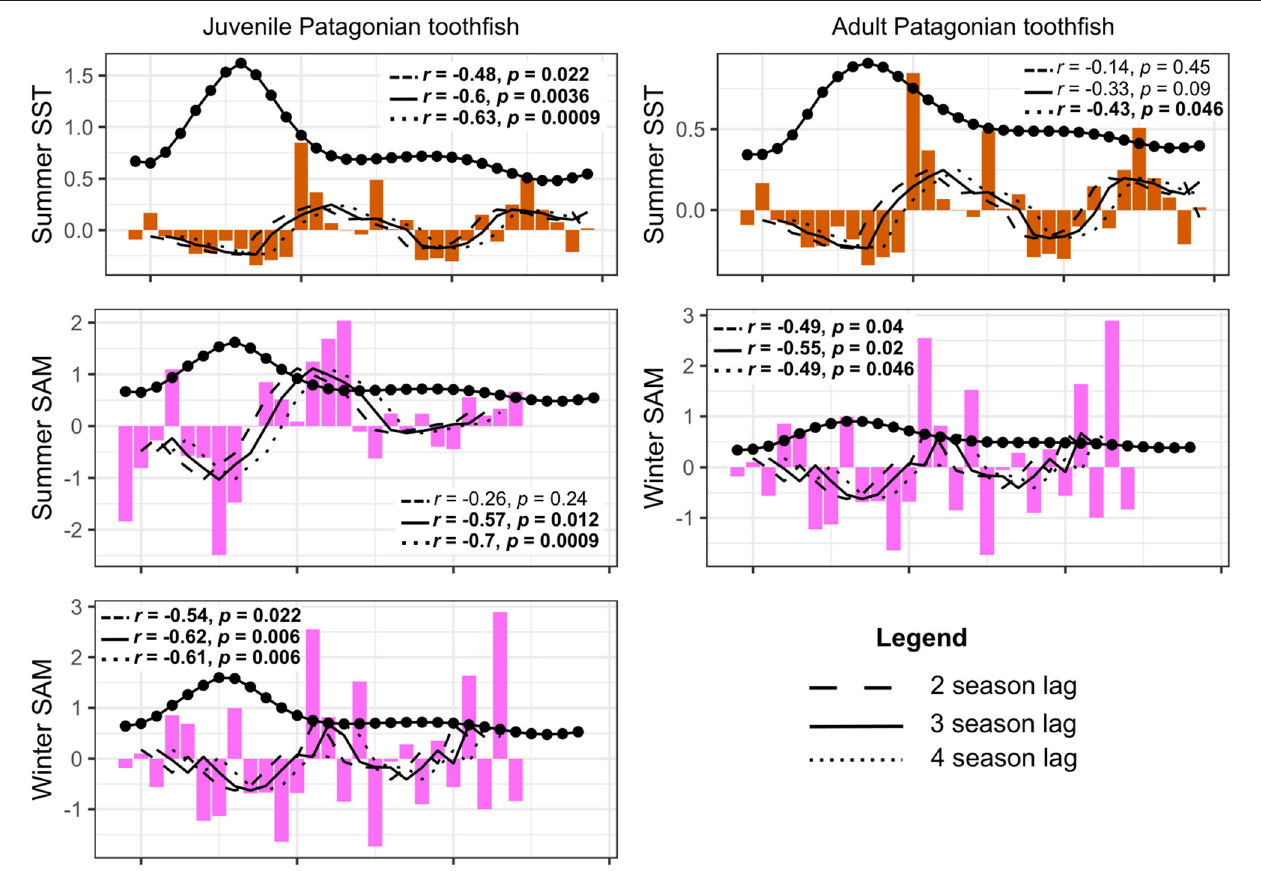
FIGURE 9 | Lagged toothfish biomass correlations to summer SST, summer SAM and winter SAM. Biomass was lagged at two (dashed line), three (solid line), and four time-steps (dotted line), equivalent to 1, 1.5, and 2 year lags, respectively. R and p values are shown in plots with associated lagged time-step, significant correlations are shown in